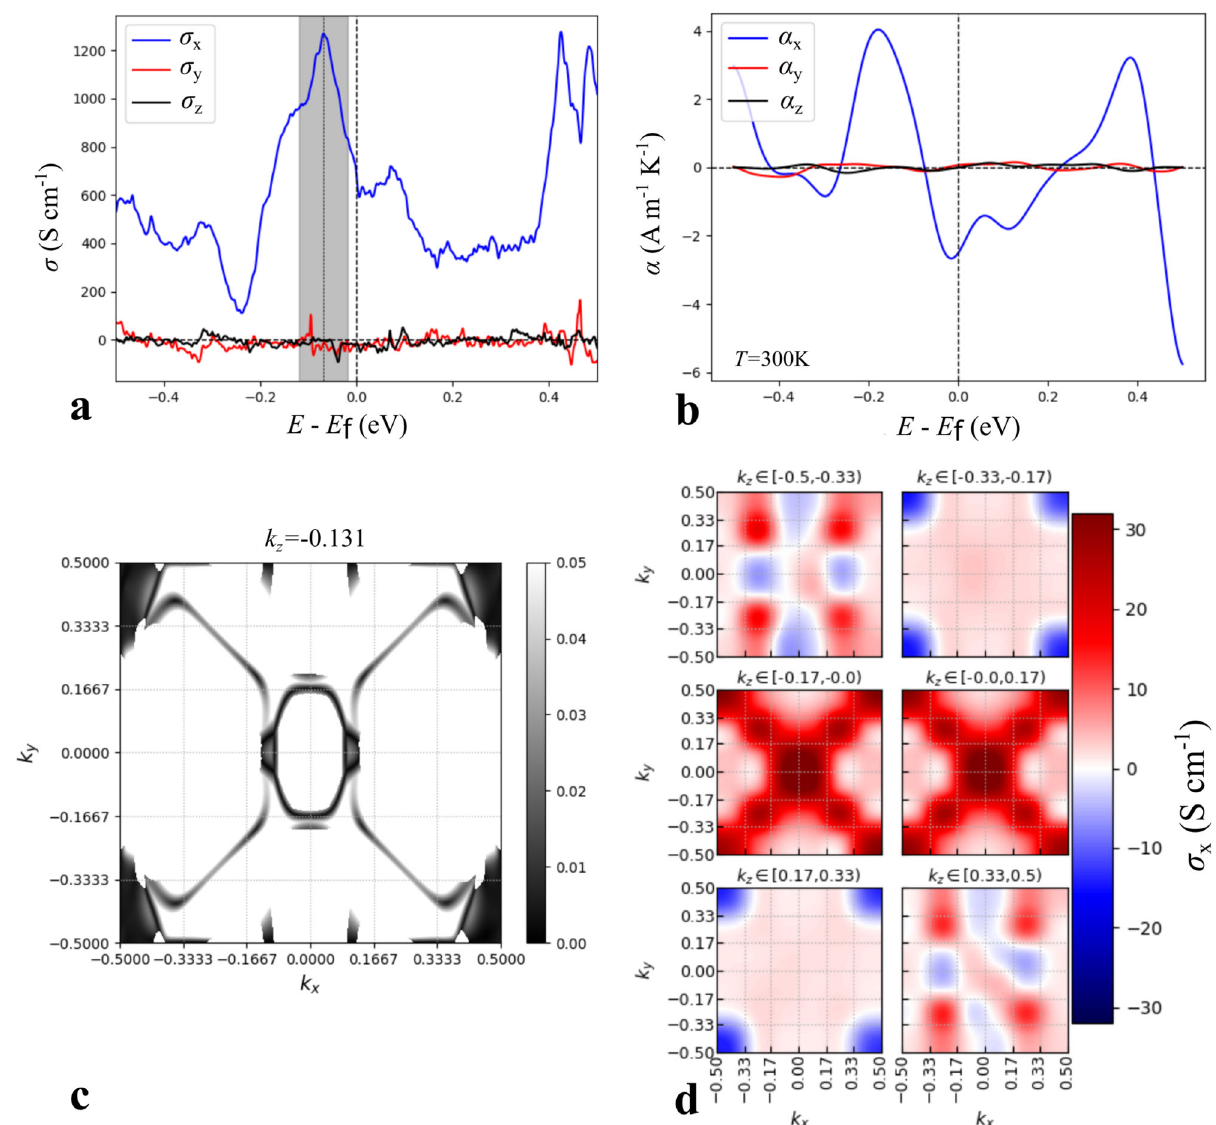
Fig. 4 Anomalous Hall/Nernst conductivities and Band gap of Fe 3 Sn with M ∣∣ [100]. a AHC components as a function of energy. b ANC components as a function of energy. c The band gap (eV) for a BZ-slice at k z = − 0.131 with its energies within the shaded energy range of part ( a ). d The distribution of the x-component ( σ x = σ yz ) of the full AHC at each part of the